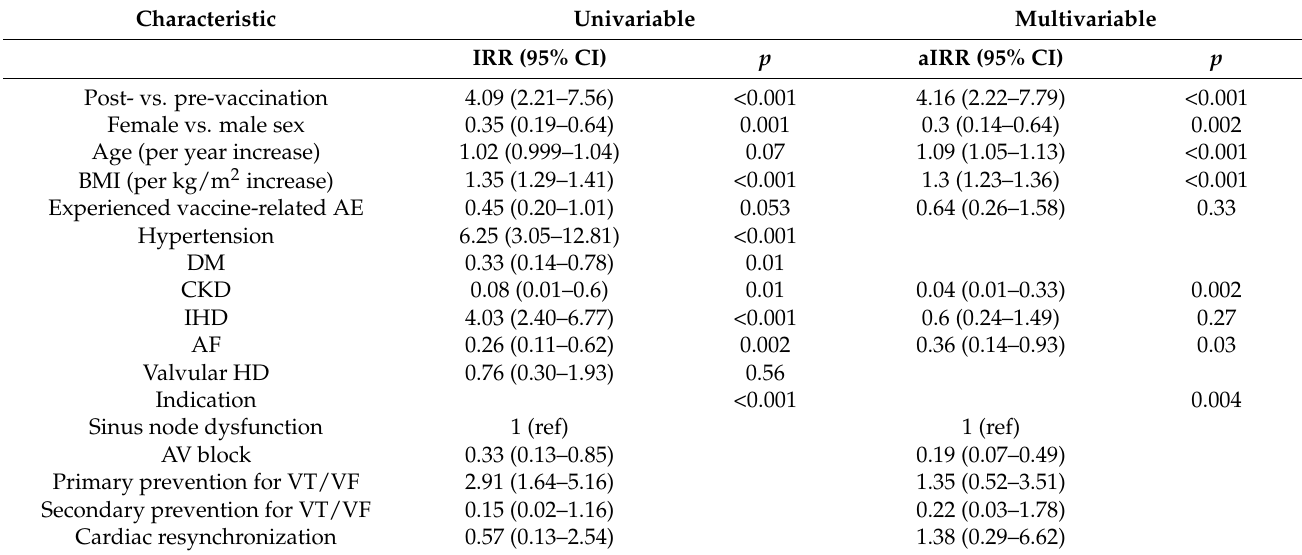
Table 5. Univariable and multivariable incidence rate ratios for VT.